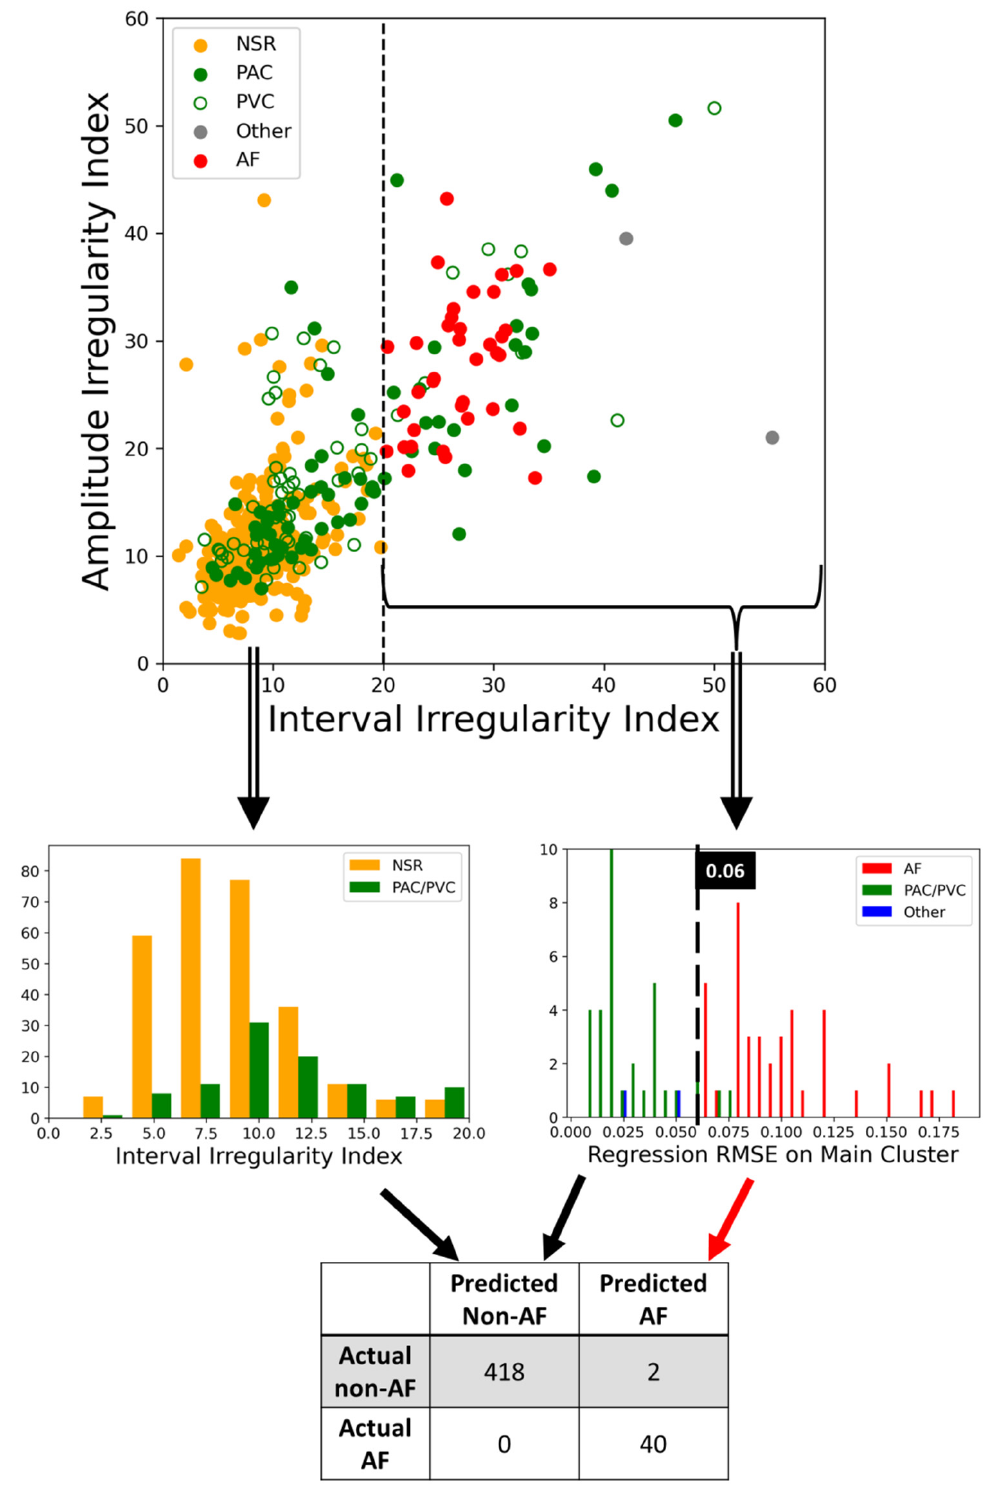
Figure 5. Irregularity distribution of different types of heartbeat rhythm and automatic detection process of separating AFib from different arrhythmic rhythm with irregularity and RMSE of orthogonal regression on the main cluster from ( t i , H i ) relation.